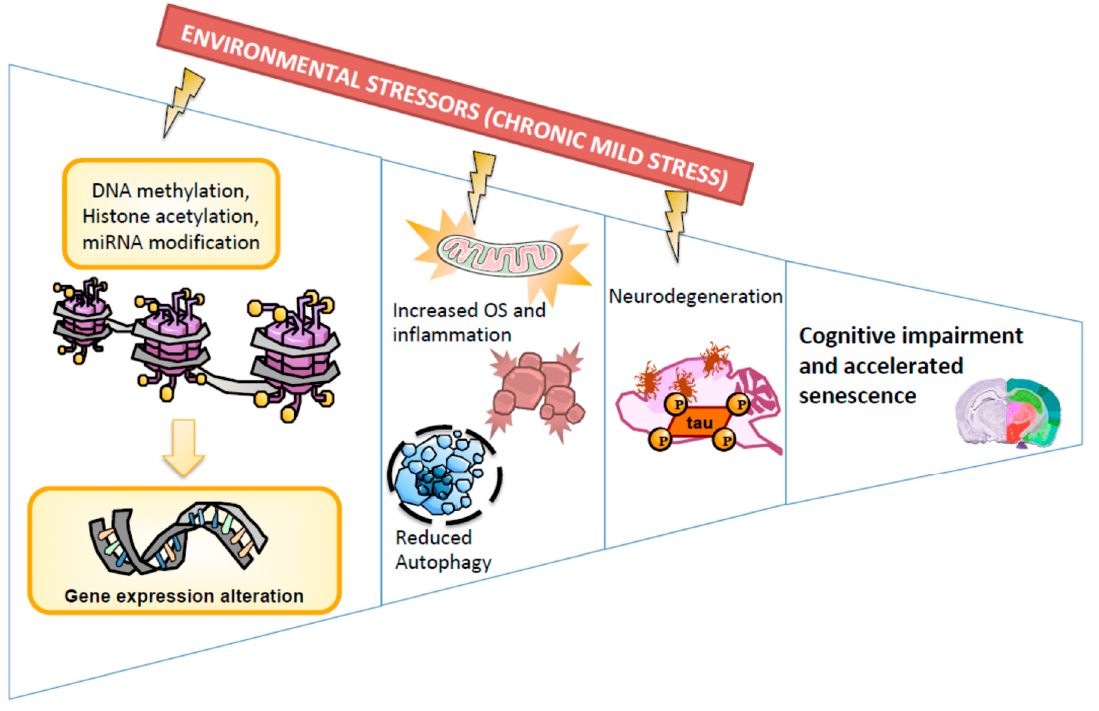
Figure 8. Representative scheme of molecular pathways altered after Chronic Mild Stress.